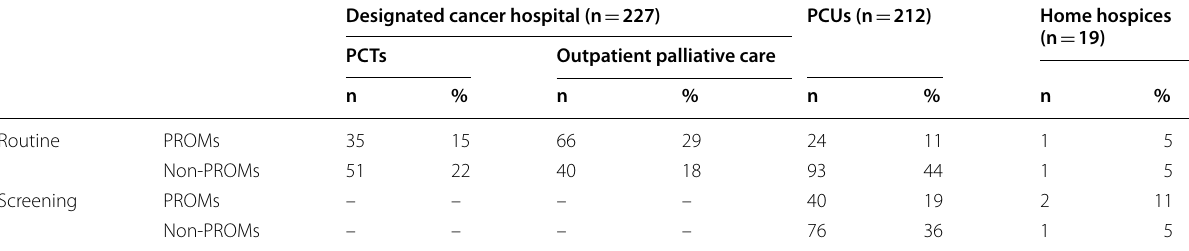
Table 1 Routine use of PROMs and non-PROM PRO assessment